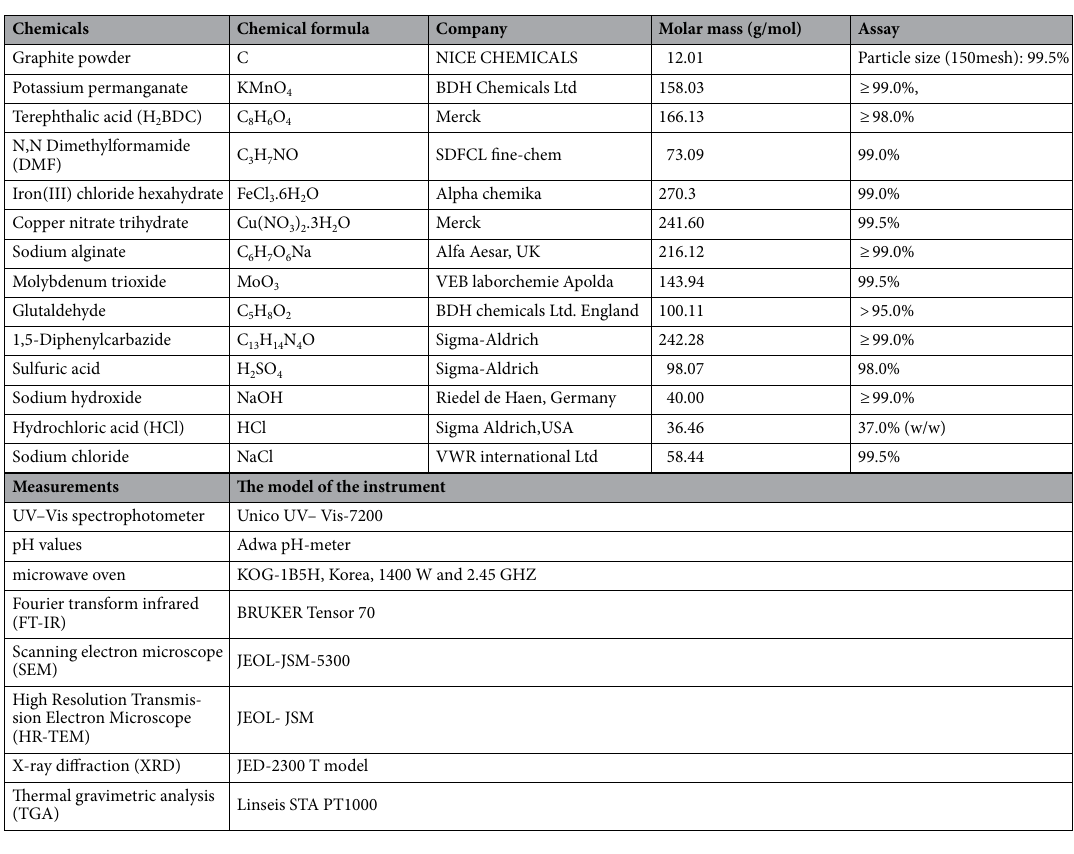
Table 1. Chemicals and